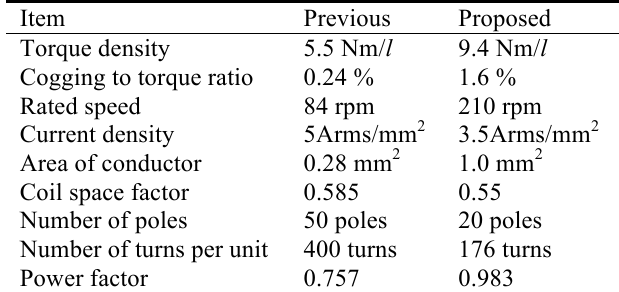
Table 5: Final specification of the prototype